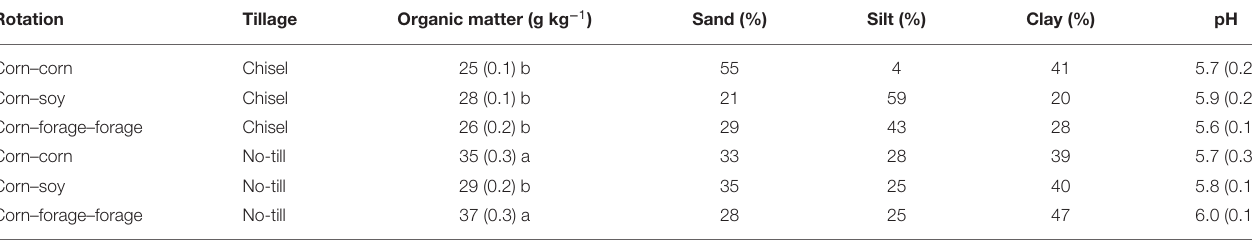
TABLE 1 | Organic matter mean and (SE) ( n = 3), sand, silt, clay, and pH mean (SE) ( n = 3) sampled in October 2020 from systems comparing three different crop rotations and two tillage intensities.